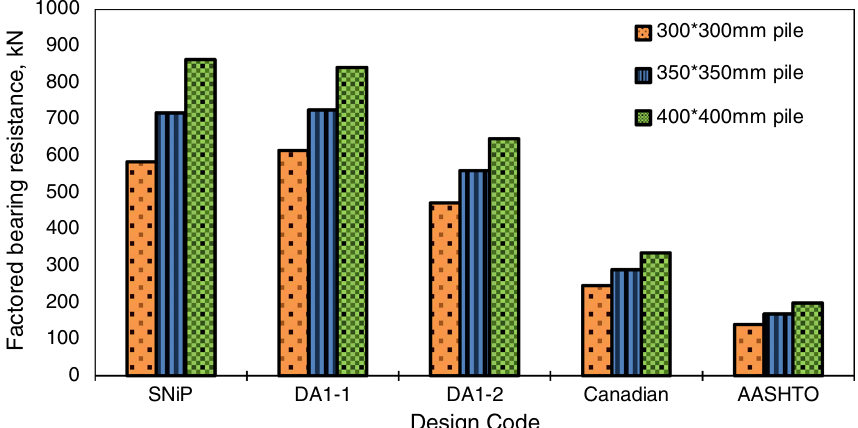
Fig. 6 Factored bearing resistance for varying pile dimensions